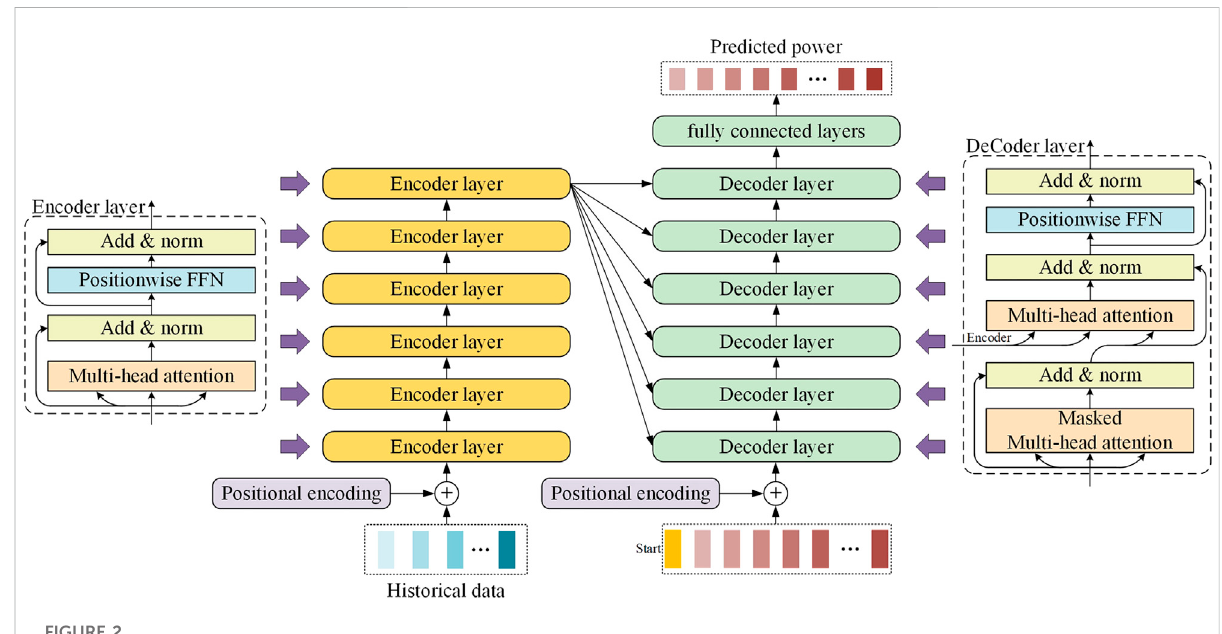
FIGURE 2 Encoder and decoder stacks of transformer.